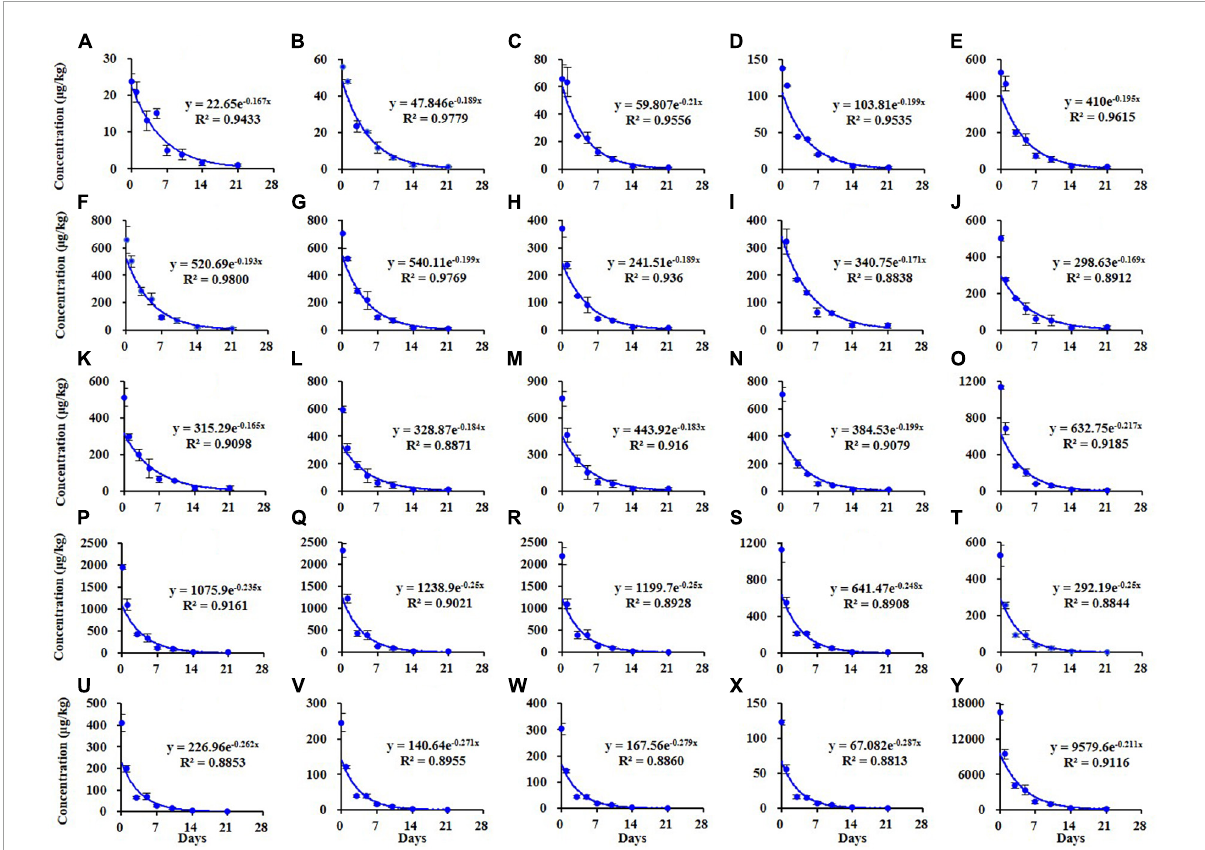
FIGURE2 Dissipation kinetics curves of different tristyrylphenol ethoxylates (TSPEOn) [ n = 6–29, (A–X) ] homologs and (cid:54) TSPEOn (Y) in cowpea in China.